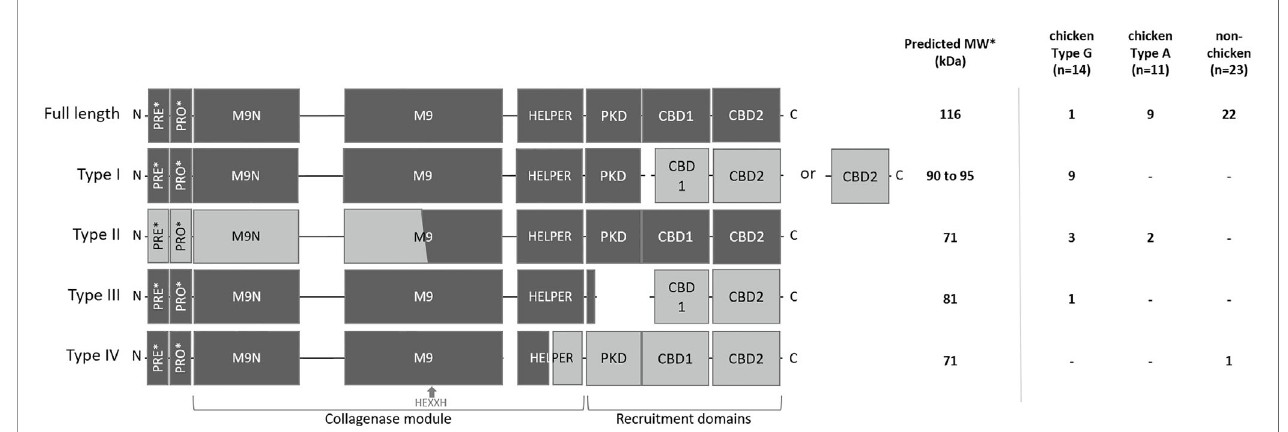
FIGURE 3 | Schematic representation and distribution of collagenase variants. Schematic representation of the domain architecture of full-length and truncated collagenase types and their distribution among chicken (type G and type A strains) and non-chicken derived C. perfringens strains (respectively n=14, n=11 and n=23). PRE = signal sequence, PRO = pro-domain, M9N = activator domain, M9 = peptidase domain, HELPER = peptidase helper domain, PKD = polycystic kidney disease-like domain and CBD = collagen binding domains. Collagenase variant types are encoded by gene variants carrying a premature stop mutation in the colA gene which results in the occurrence of 2 protein-coding regions. Predicted active fragment containing the HEXXH motif is represented in dark grey, while the other fragment which is expected to be inactive is represented in light grey. *PRE & PRO domains are removed upon maturation. Molecular weight of the predicted mature active fragment is